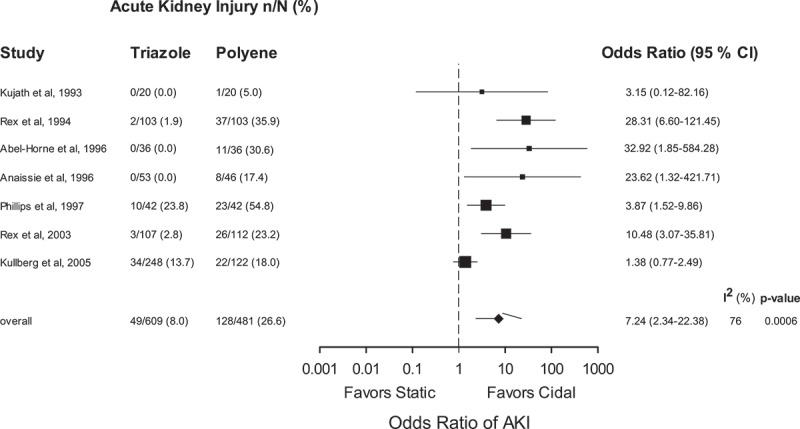
Renal injury during or following therapy for trials comparing fungicidal and fungistatic therapy of invasive candidiasis and/or candidemia. Only the seven studies including amphotericin B in the fungicidal arm are included. Odds ratios (ORs) are pooled using a random effects model on a logarithmic scale. The size of the squares is proportional to the reciprocal of the variance of the studies. CI: confidence interval, n/N: frequency of finding, AKI: acute kidney injury.